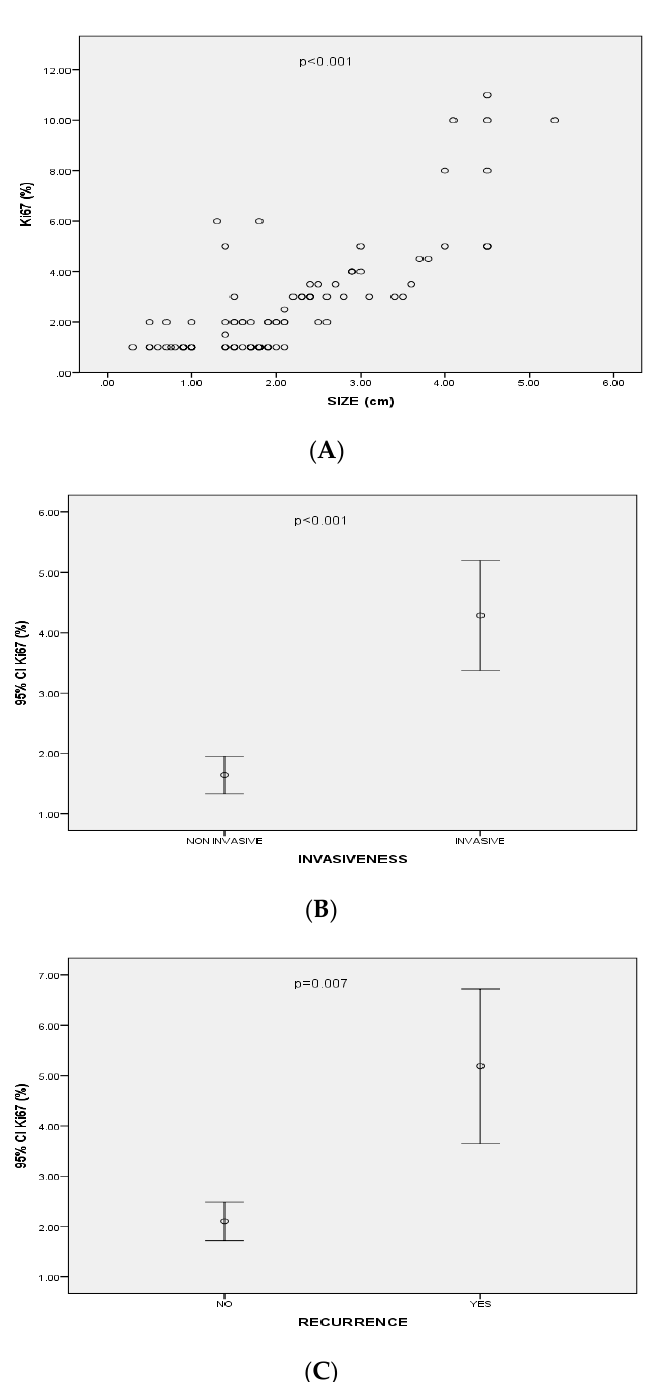
Figure 3. ( A ) Correlation between Ki-67 expression and size of pituitary adenomas ( p < 0.001, r= 0.69); ( B ) Mean values of Ki-67 expression (95%CI) associated with invasiveness of pituitary adenomas; ( C ) Mean values of Ki-67 expression (95%CI) associated with recurrence of pituitary adenomas. In NFPAs, the Ki-67 index was significantly positively correlated with their size ( p = 0.005, r = 0.36) and their recurrence ( p = 0.03, r = 0.3), as well as of their extrasellar ( p = 0.01, r = 0.3) and cavernous sinus invasion ( p = 0.002, r = 0.4). In FPAs, Ki-67 was statistically correlated with their size ( p = 0.01, r = 0.4) but not with their recurrence ( p = 0.09, 0.27). Ki-67 was also significantly correlated with the extrasellar invasion of FPAs ( p = 0.04, 0.3) but not with cavernous sinus invasion ( p = 0.2, r = 0.2).